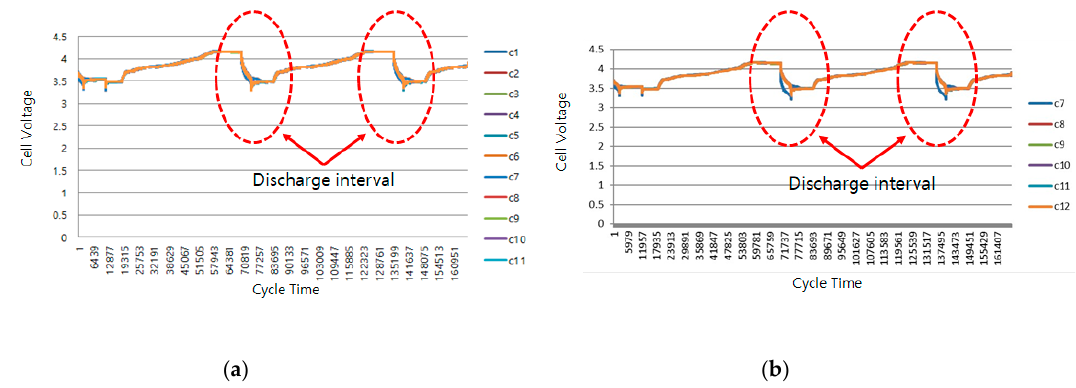
Figure 19. Cell change comparison in the discharge interval of the drones (( a ): BMS, ( b ): Battery only).